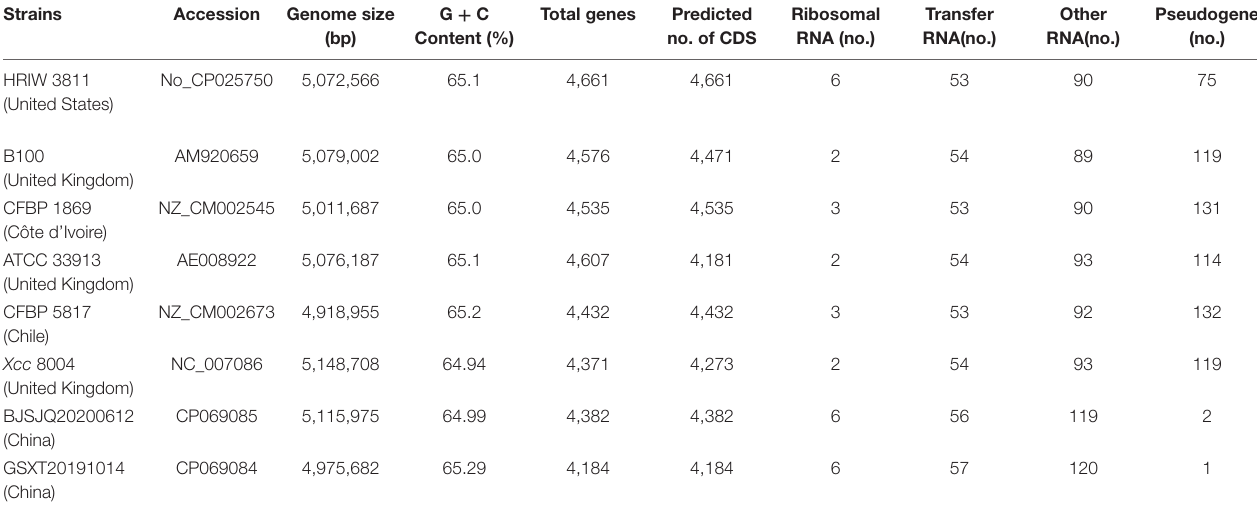
TABLE 1 | Genome features of BJSJQ20200612 and GSXT20191014 and other sequenced Xcc strains. Strains Accession Genome size